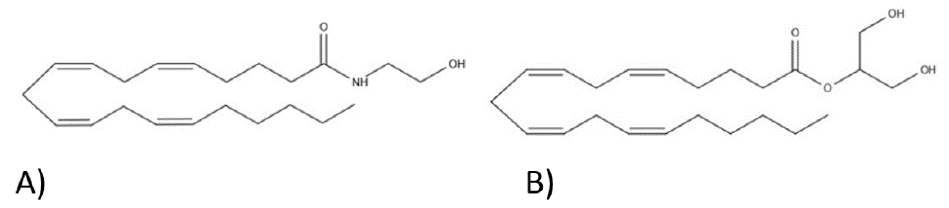
Figure 1. Endocannabinoid structures: ( A ) anandamide and ( B )